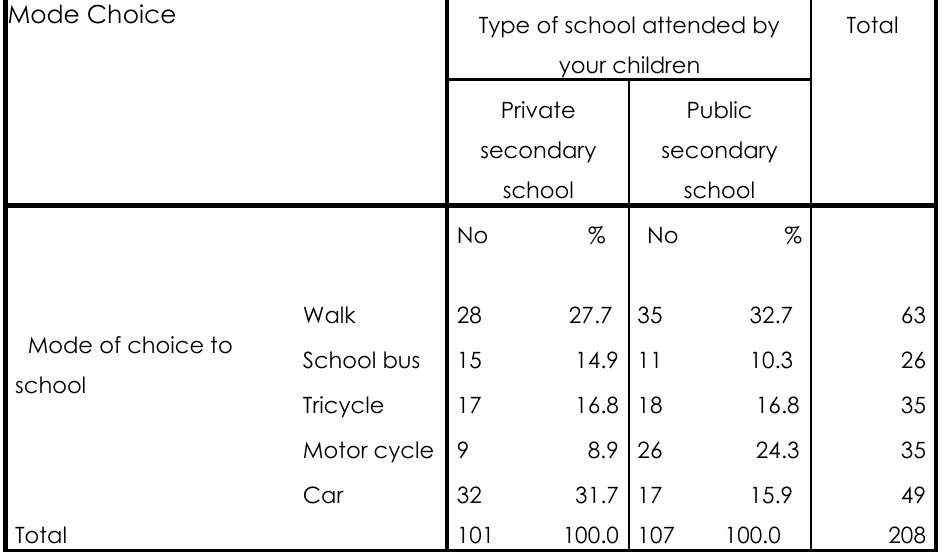
Table 2: Mode Choice of Transportation to Different Type of School in Lokoja Mode